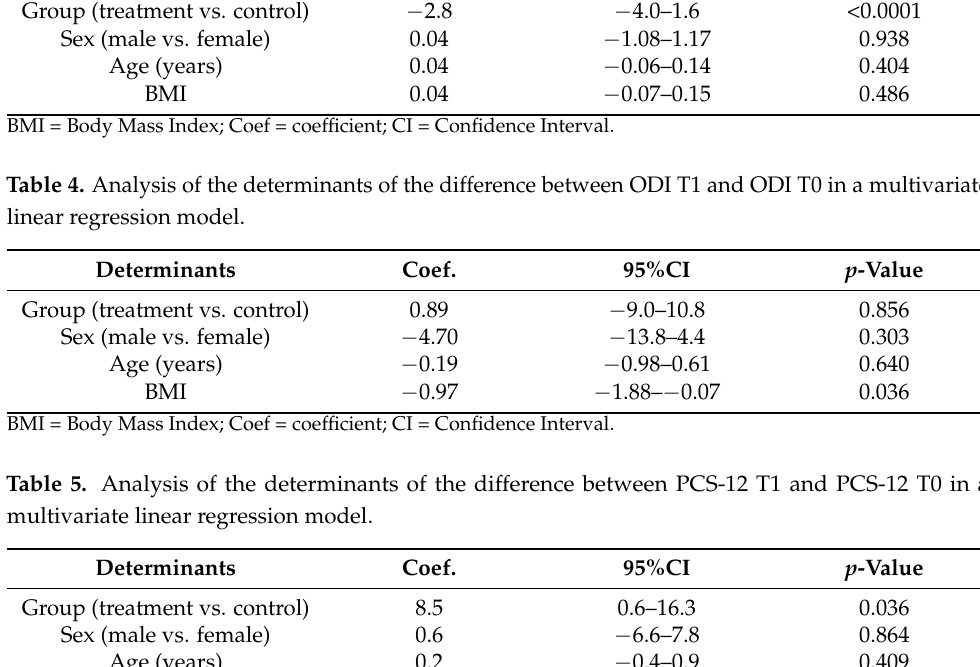
Table 3. Analysis of the determinants of the difference between NRS T1 and NRS T0 in a multivariate linear regression model. Determinants Coef. 95%CI p -Value Group (treatment vs. control)